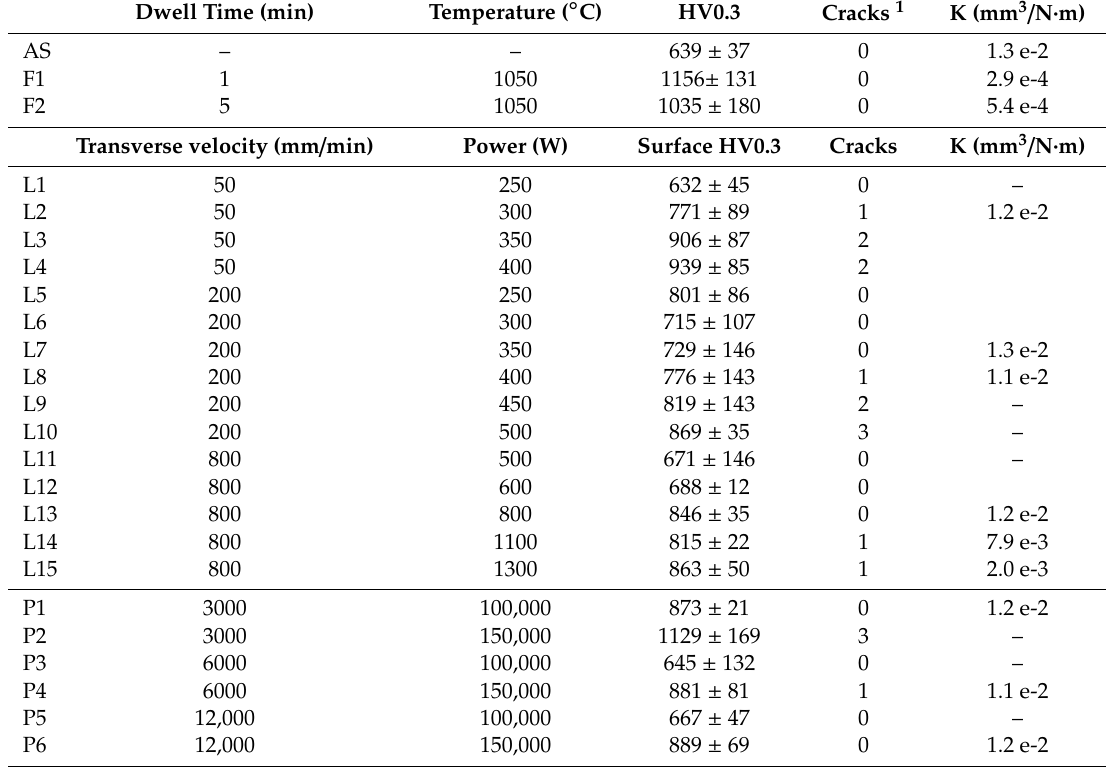
0—no cracks, 1—short vertical cracks, 2—long vertical cracks, 3—vertical and horizontal cracks.